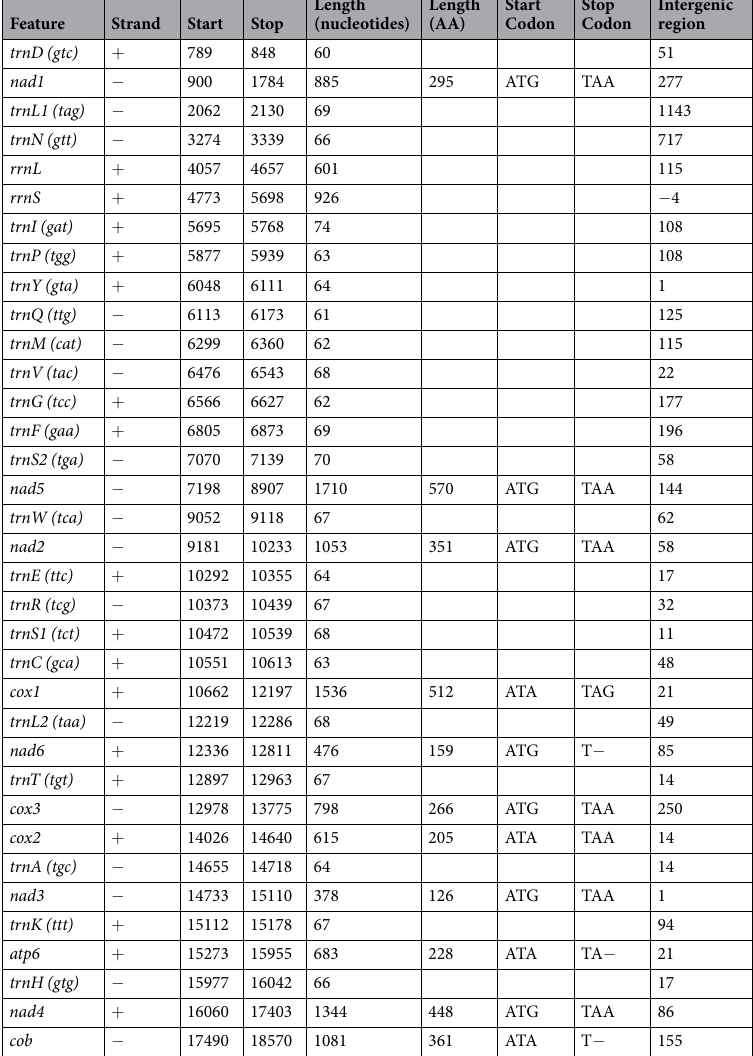
Table 2. Organisation of the Isodiametra pulchra 18.7 kb mitochondrial genome